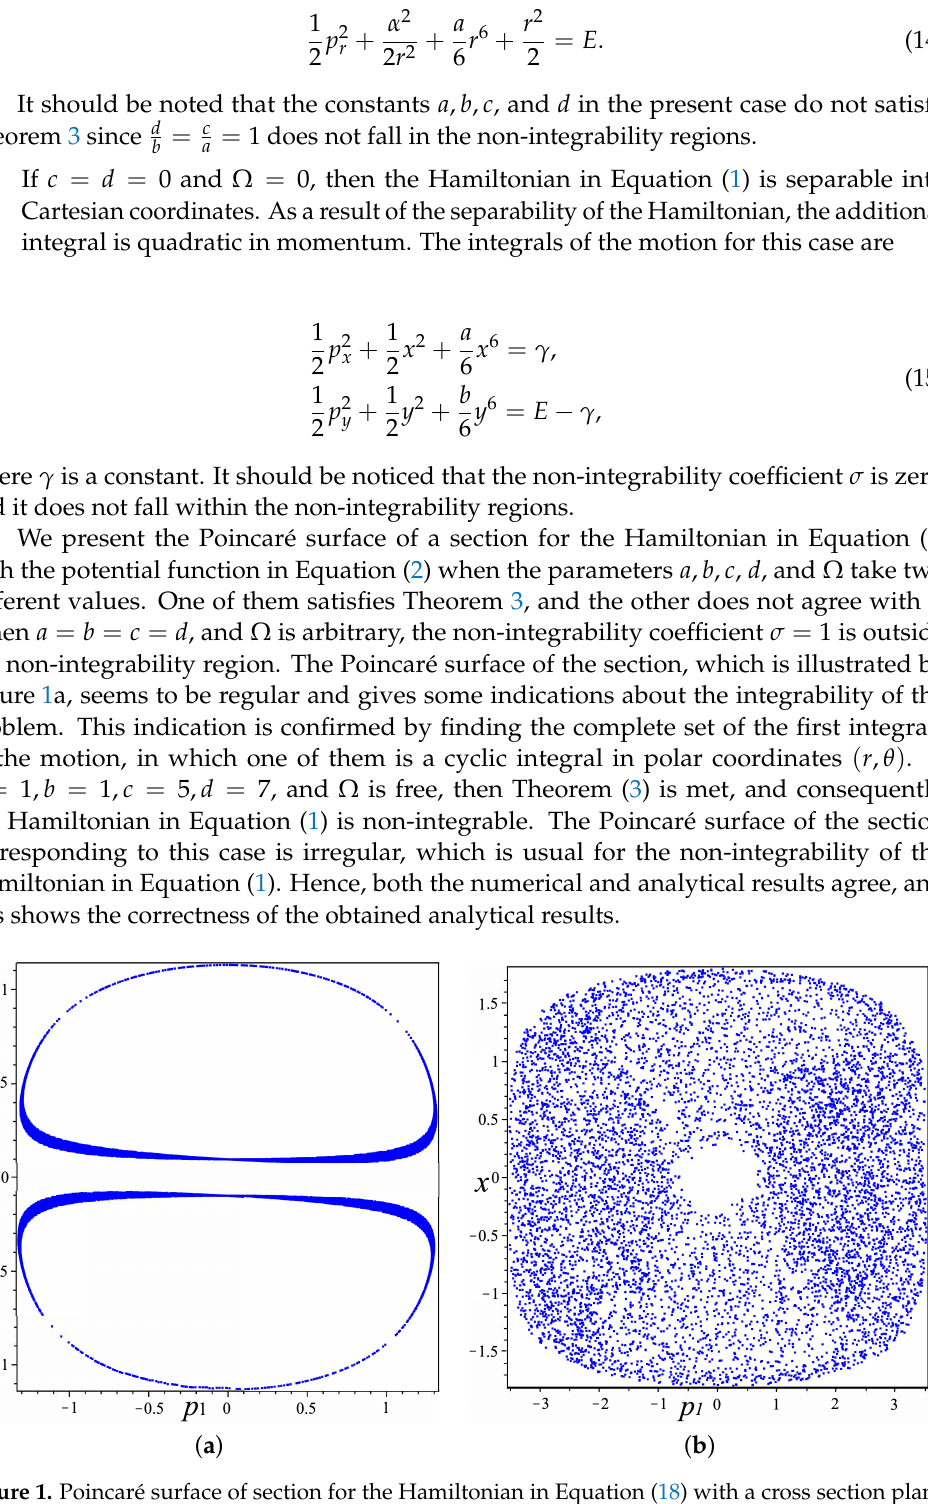
Figure 1. Poincaré surface of section for the Hamiltonian in Equation (18) with a cross section plane ( x , p x ) on the Jacobi integral level, where ( a ) E = 0.00962 and ( b ) E =